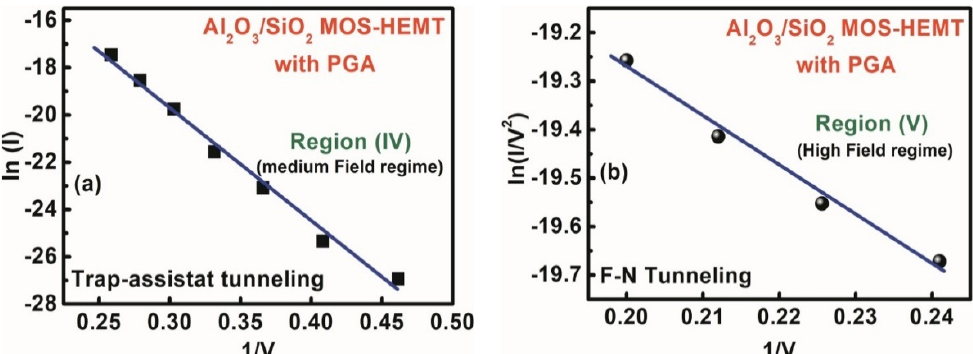
Figure 10. Gate leakage conduction mechanism of the Al 2 O 3 /SiO 2 MOS–HEMT after gate annealing treatment ( a ) region IV, ( b ) region V.